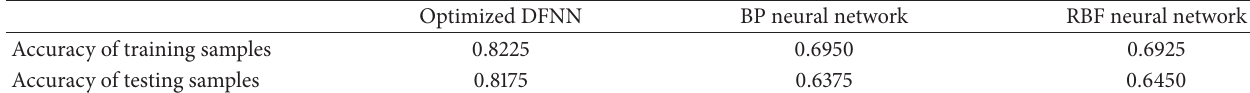
Table 3: The prediction accuracies of three networks.